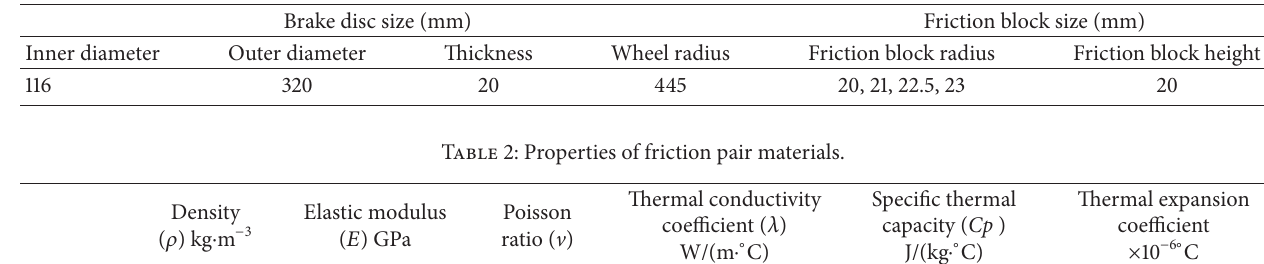
Table 1: Geometric parameters of brake disc and cylindrical friction blocks.